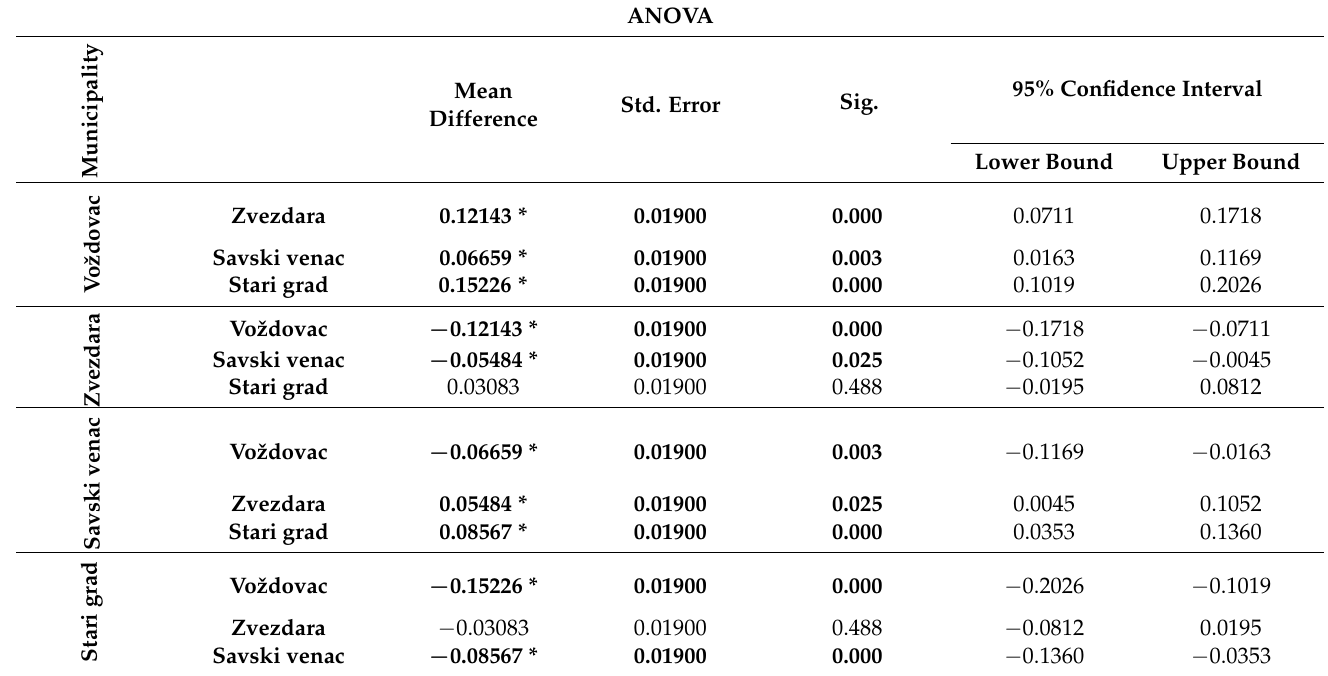
Table 6. Analysis of variance for the NDVI values per